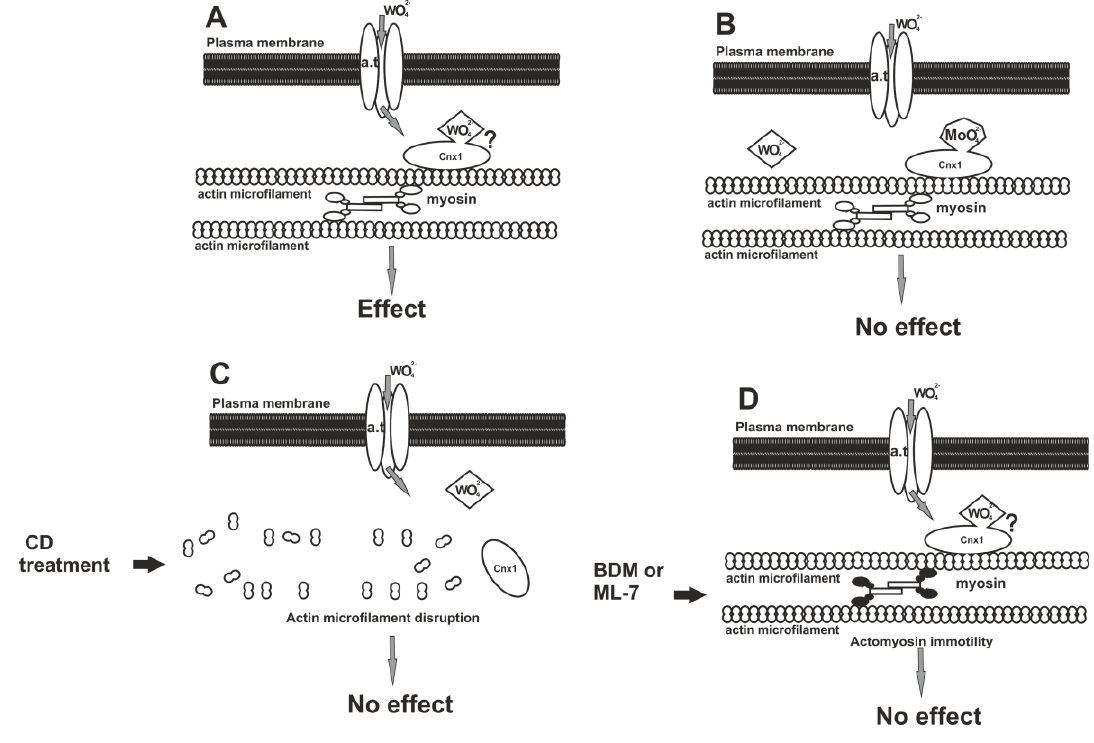
Figure 2. A model for the entry of W in the plant cell, through the pathway of